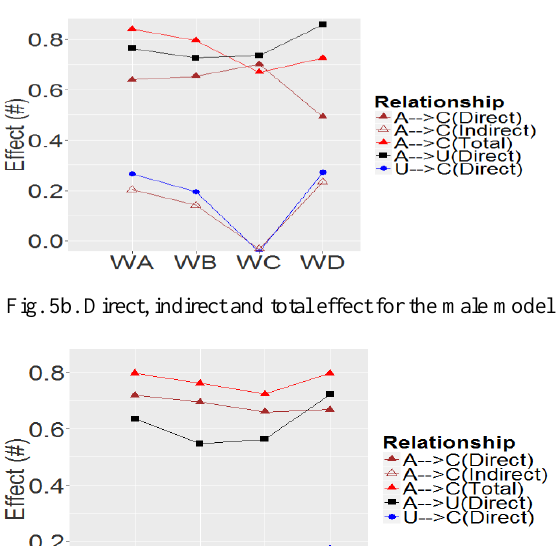
Fig. 5a. Direct, indirect and total effect for the global model